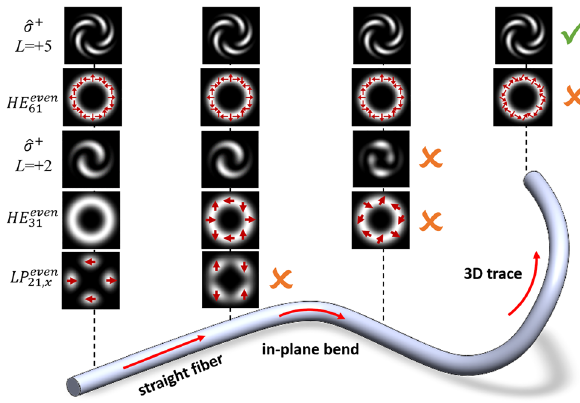
Figure 8: Summary of the propagation stability of optical fiber modes of different classes when the fiber is deployed with commonly encountered perturbations. The illustration depicts modes launched at the left end of a perfectly circular fiber, and all modes are schematically illustrated at four positions (black dashed lines) along the fiber propagation axis. From left to right: The input comprises pure modes in all the classes; the second position represents propagation through a straight fiber without any perturbations; this is followed by a position after propagation through a fiber that is bent only in plane; and, the final position represents propagation through a fiber that experiences an out-of-plane (3D) redirection as well. The modes from bottom to top ) , represent LP modes (LP 2,1 ), low order vector modes ( EH even 3 , 1 ) , low-order OAM modes ( L (cid:1) 2 (cid:6) σ + ) , high-order vector modes ( EH even 6 , 1 andhigh-orderOAMmodes ( L (cid:1) 5 (cid:6) σ + ) .Afterpropagatingthroughthe straight fi ber section, LP modes mix between orthogonal modes of thesameclass,whereasalltheothermodesremainstable.Assuch, LP modes, designated at this point with an orange cross, are not illustrated across subsequent perturbations, having failed to propagatethroughthe most elementary arrangement. In-plane fi ber ) or orbital angular bends easily couple a low-order vector ( EH even 3 , 1 momentum (OAM) ( L (cid:1) 2 (cid:6) σ + ) mode with its degenerate counterpart, while it does not impart enough angular momentum to couple a higher-order OAM mode L (cid:1) 5 (cid:6) σ + or the corresponding vector mode EH even totheirrespectivedegeneratecounterparts.Again,therefore, 61 no further depiction of low L vector or OAM modes is illustrated (as indicated by the orange cross). After propagating through the 3D trace, a higher-order vector mode EH even mixes completely with its 6 . 1 degenerate counterpart, whereas the corresponding OAM mode L (cid:1) 5 (cid:6) σ + merely acquire a common geometric phase and remainsremarkablystable.Hence,acrossallperturbations,onlythe high | L | OAM mode survives without coupling, to its degenerate or nondegenerate